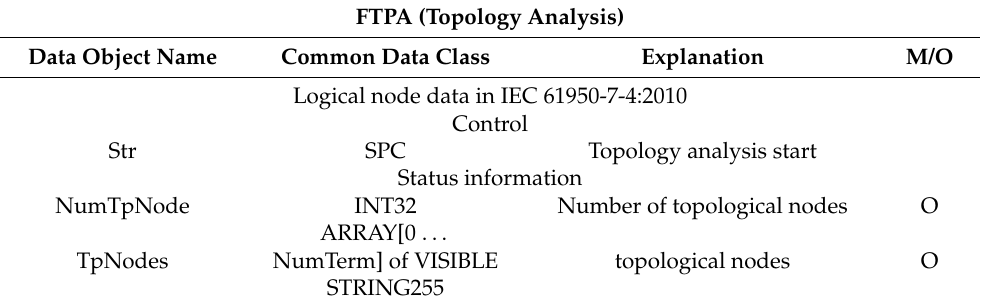
Table 5. Logical node FTPA.